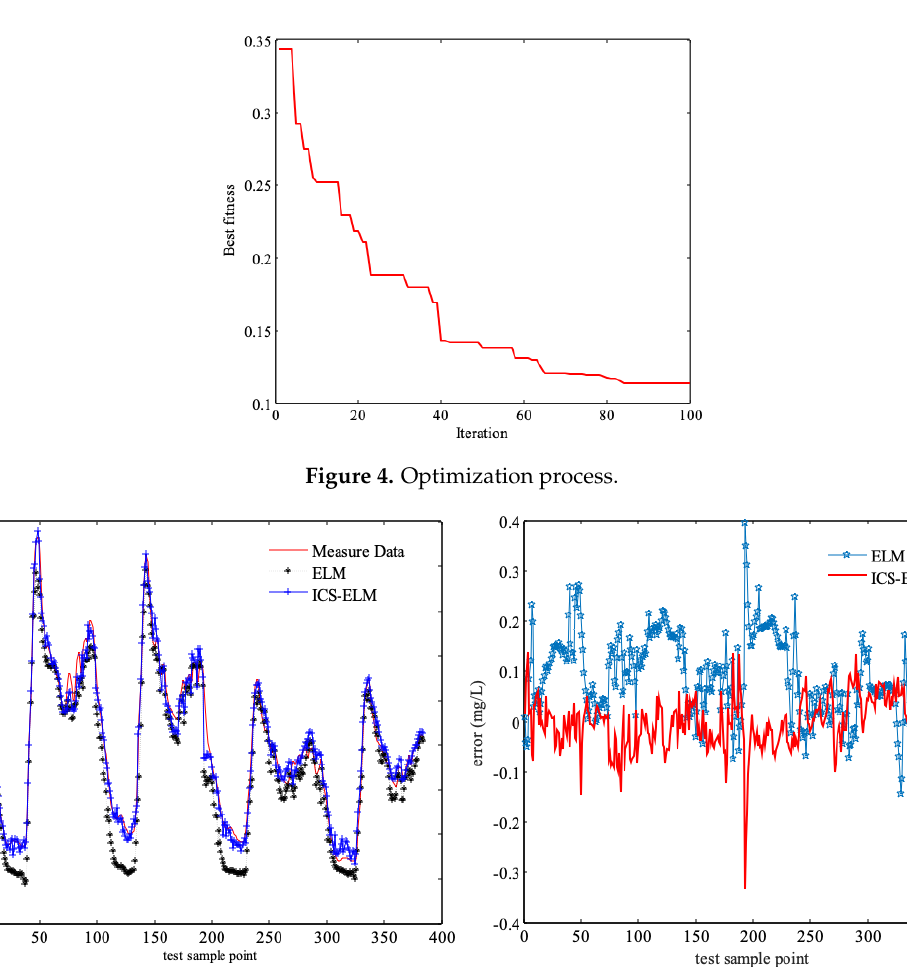
Table 3. Prediction results of the six soft sensor models. MSE: mean square error; CS-ELM: cuckoo search-extreme learning machine; RVM: relevance vector machine; BP: back propagation; LS-SVM: least squares support vector machines.